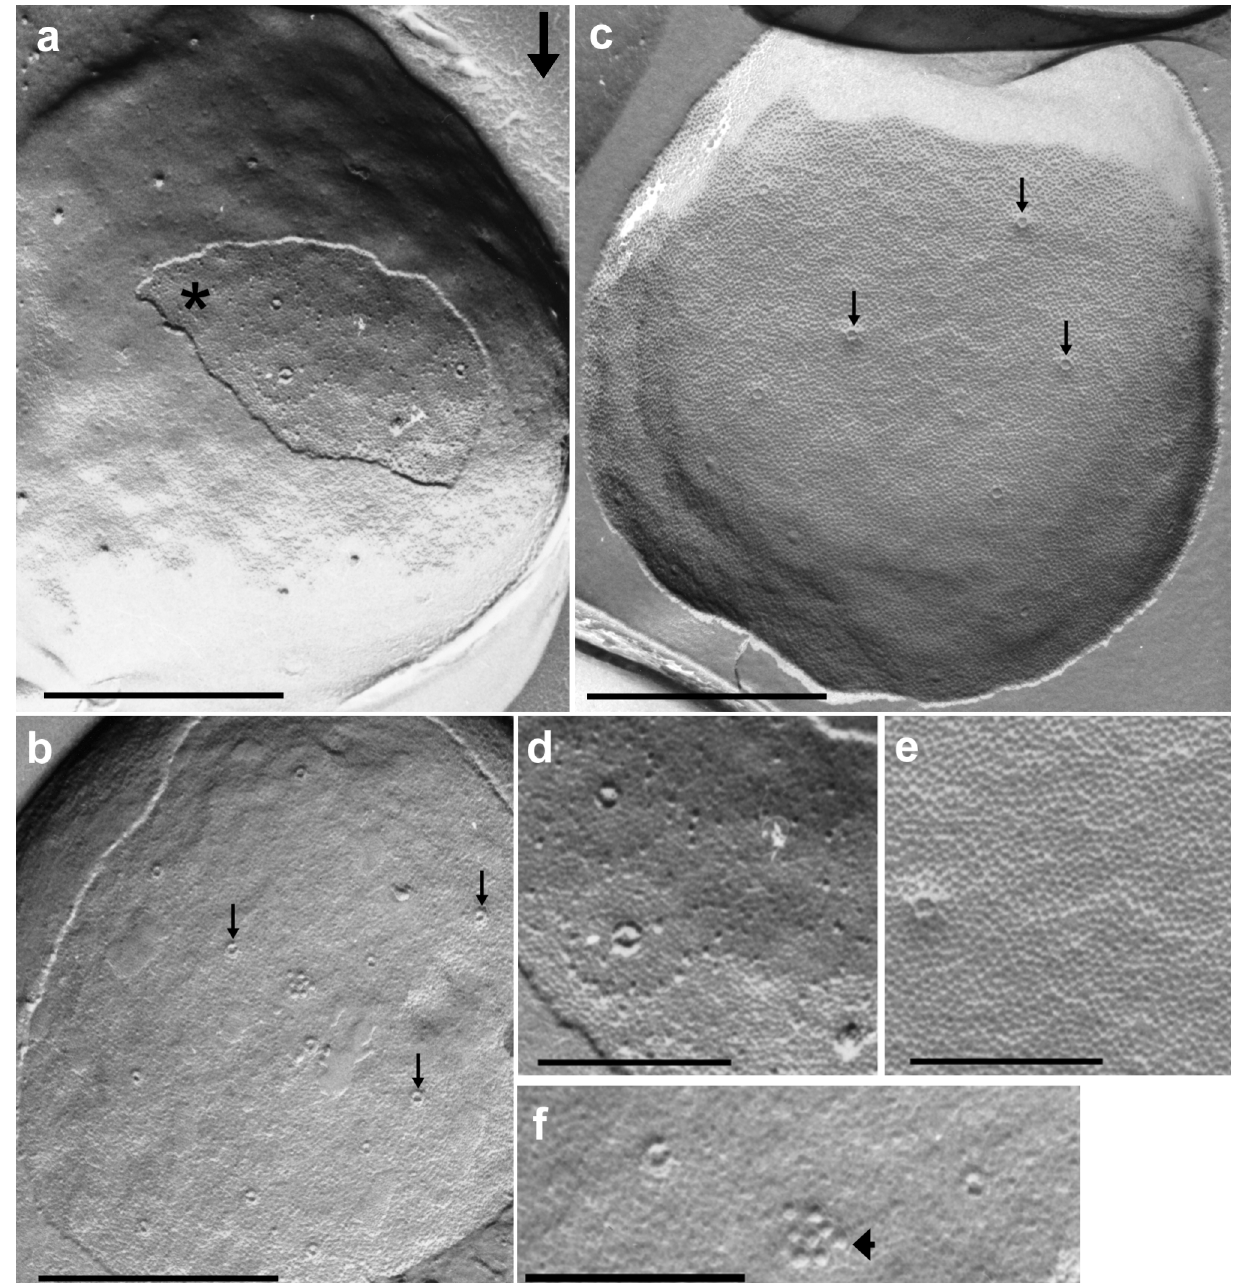
Figure 4. Electron micrographs of freeze-etched Ignicoccus . The arrow in (a) indicates the direction of the platinum shadowing. (a) View of the smooth cell surface; the star marks the area of the fractured outer membrane; bar = 0.5 µm. (b) View of the fractured area of the outer membrane, with 12 particles(24-nmpores), threeof which are marked by arrows; bar = 0.5 µm. (c) View of the innerfractureface of the outermembrane,with densely packed 8-nm particles, and with at least six 24-nm pores, three of which are marked by arrows; bar = 0.5 µm. (d) Detail of (a) at higher magnification, with two 24-nm pores. (e) Detail of (c) at higher magnification, with one 24-nm pore. (f) Detail of (b) at higher magnification, with two 24-nm pores, and a “group-of-8” particle (flagella), marked by arrowheads; bar in d–f = 0.2